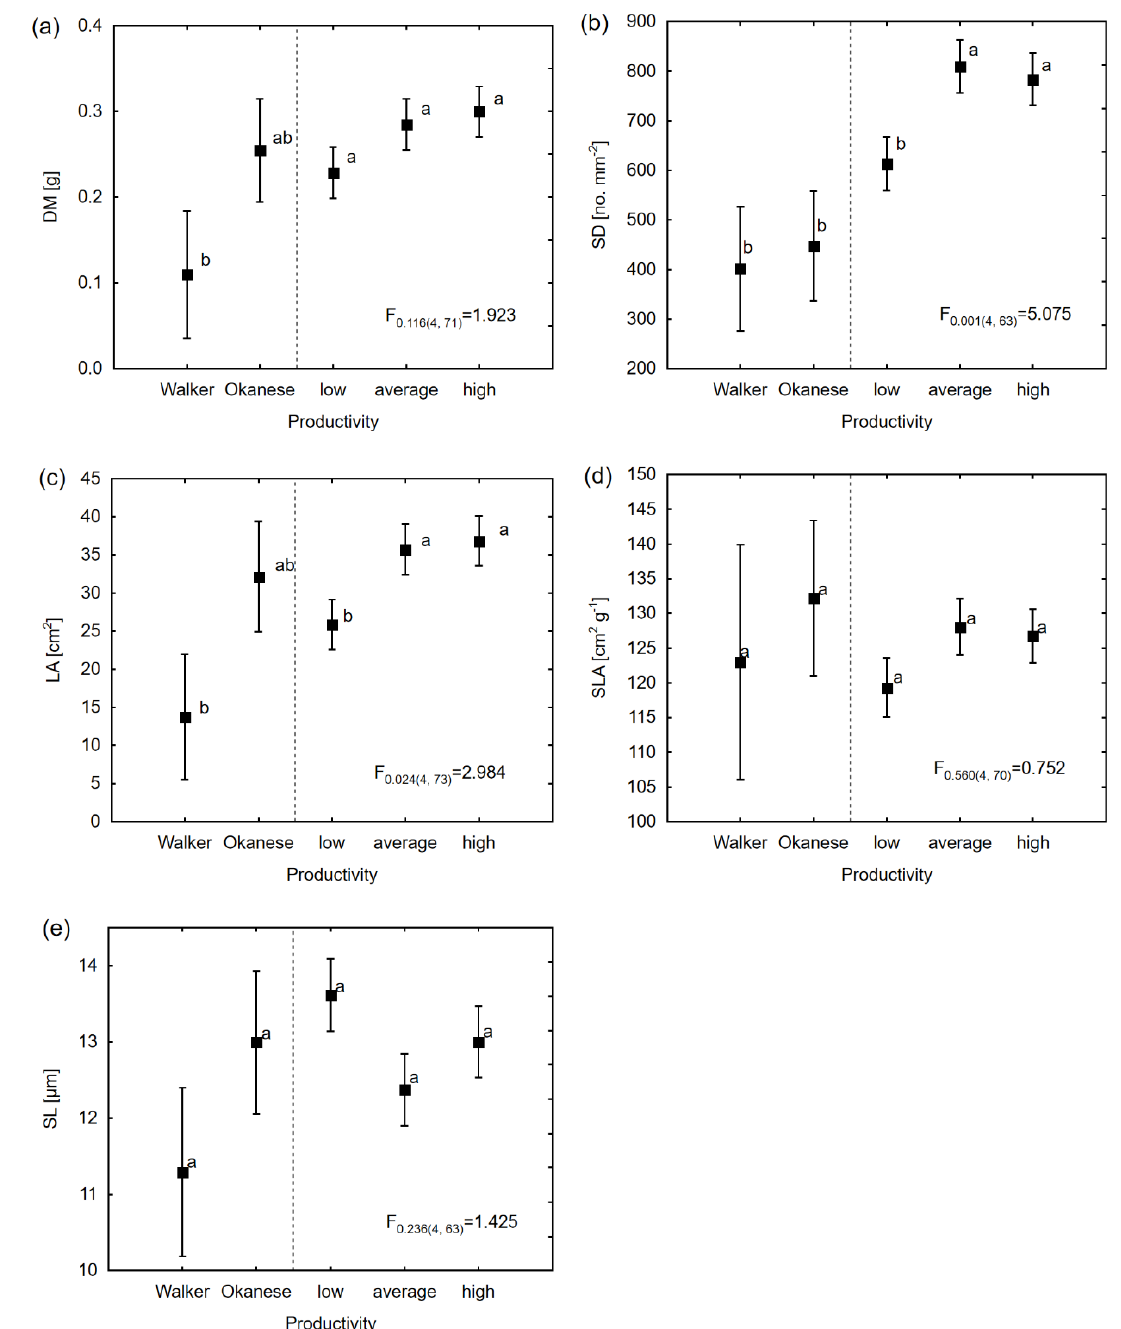
Figure 3. Estimated means for morphological traits in the linear mixed model and results of the LSD test for: ( a ) DM; ( b ) SD; ( c ) LA; ( d ) SLA; ( e ) SL. The same letters signify homogeneous groups ( α = 0.05) in the post-hoc LSD test. The F-test values for productivity groups are shown with their p -values, followed by the degrees of freedom in brackets. The meaning of the trait abbreviations as in the Table 2 footnote.